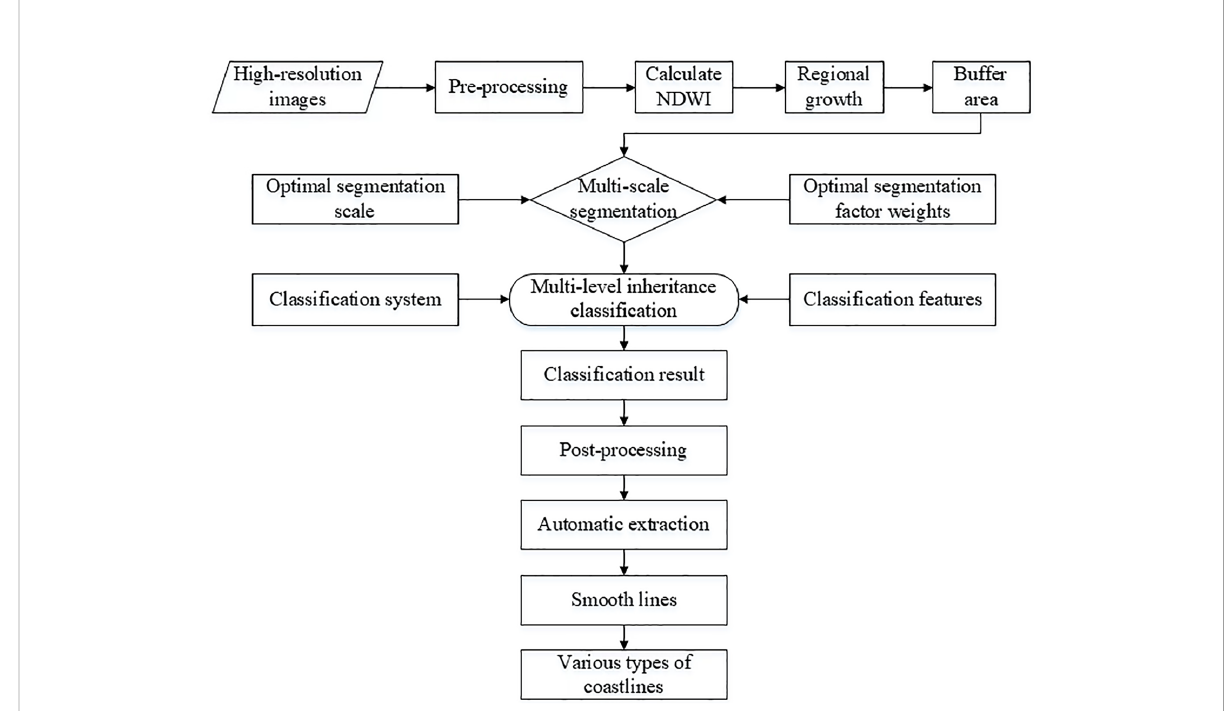
FIGURE 1 The overall methodology fl owchart adopted in current research work for coastline